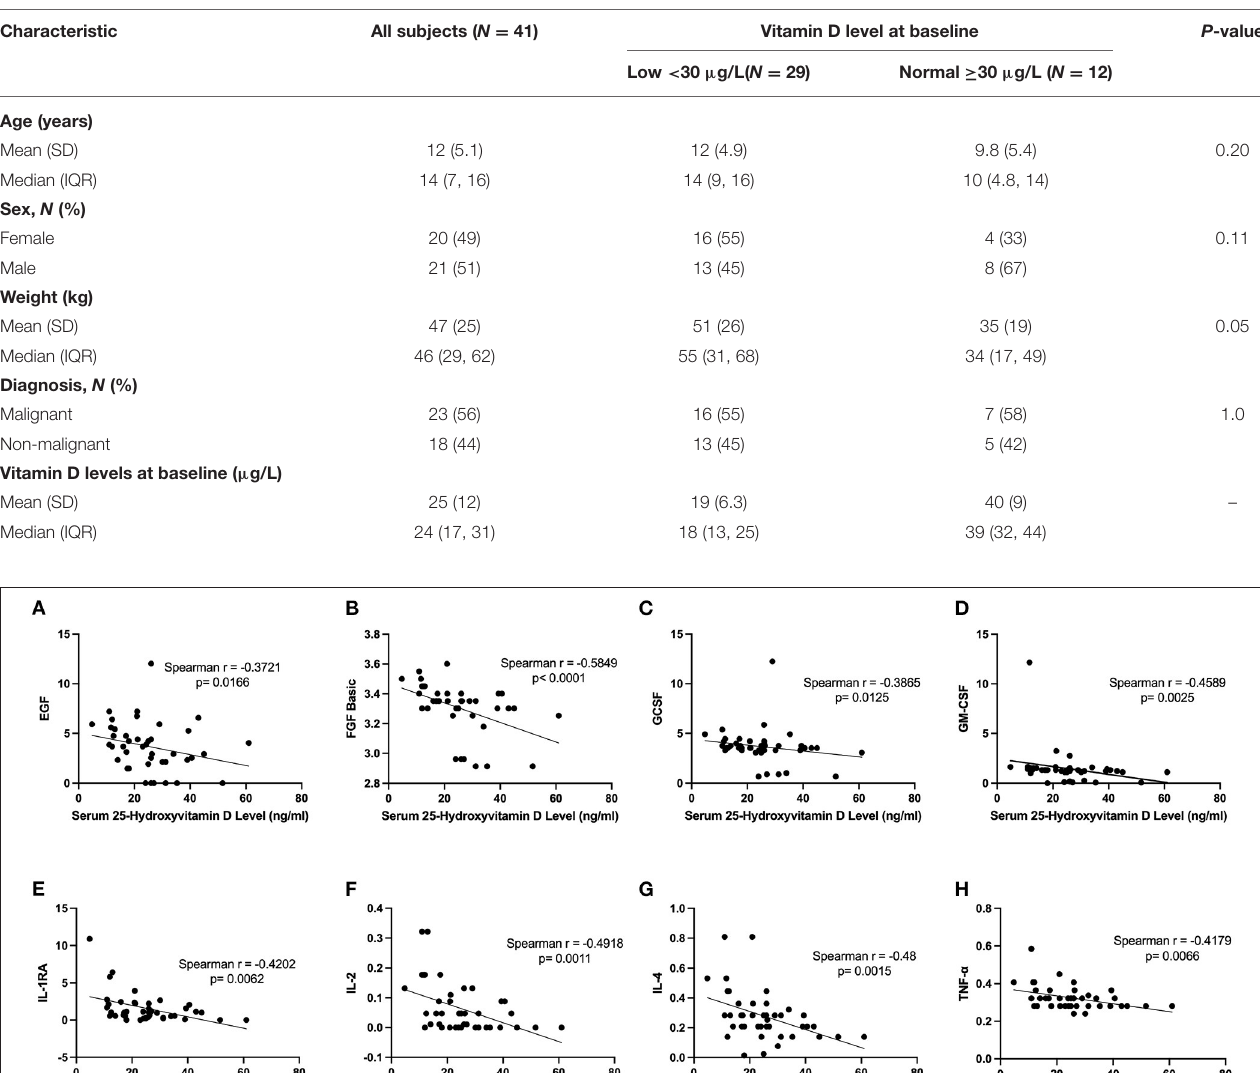
TABLE 1 | Demographic and characteristics of HSCT patients according to Vitamin D levels at baseline. Characteristic